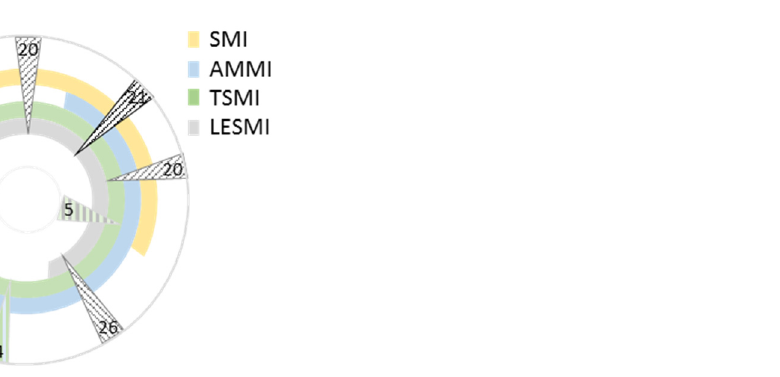
Figure 4. Comparison of the number of sarcopenic individuals identified by ASM-based indices and ASM. Each partial circle depicts an index or ASM. The number in the partial circles indicates the number of individuals recognised as sarcopenic per index. The black numbers reaching over two differently coloured partial circles represent the number of individuals recognised by the two compared parameters. The striped area shows the number of persons identified as sarcopenic,